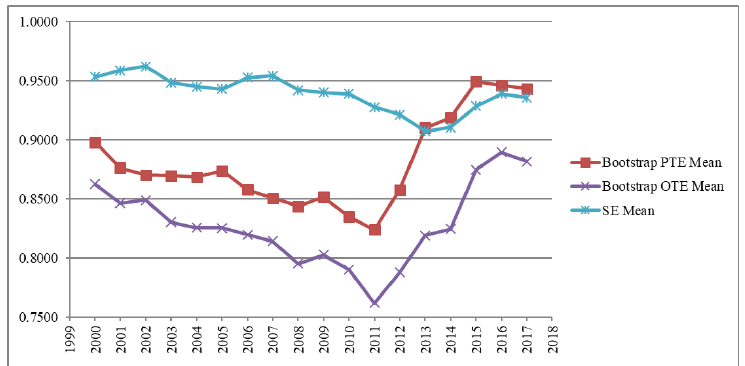
Figure 2. Annual bootstrap OTE, bootstrap PTE, and the SE for the first stage.